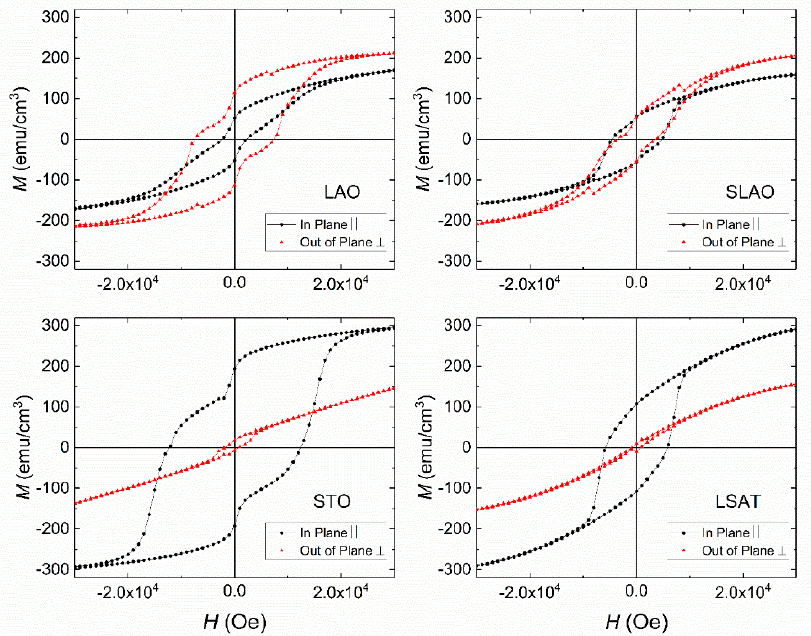
Figure 8. In-plane (IP) and out-of-plane (OOP) hysteresis loops performed at 5 K on LSCO films grown on the LAO, SLAO, STO, and LSAT substrates for the ~28 nm thickness.